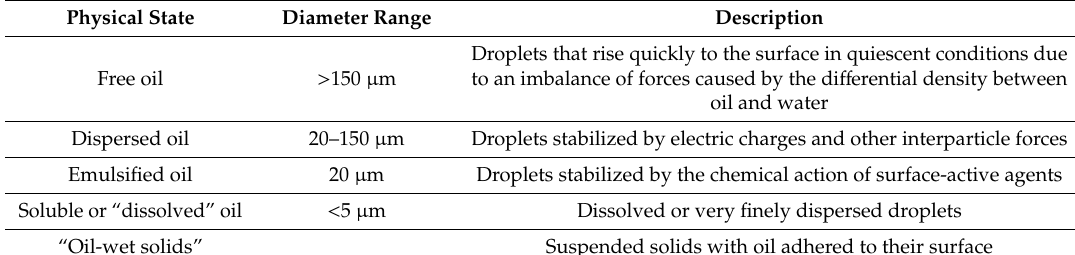
Table 1. Physical classification of O&G droplets (adapted) from Patterson [7] and Rhee et al. [8].